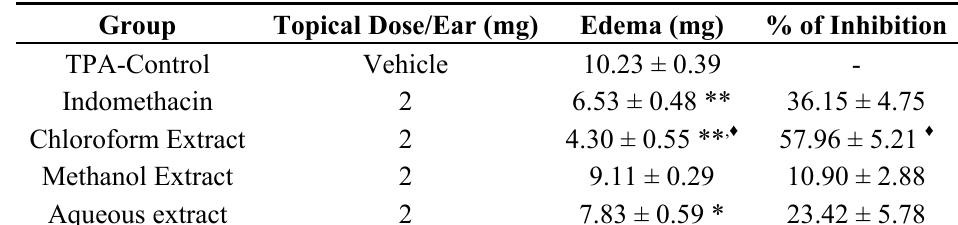
Table 1. Anti-inflammatory effect of different extracts from Senna villosa leaves in TPA-induced ear edema.